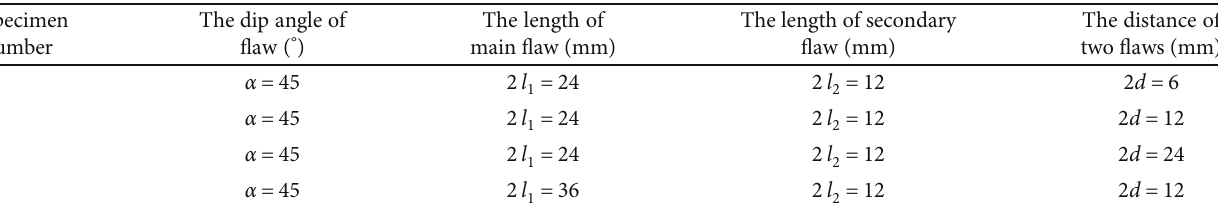
Table 5: Flaw geometric parameters in specimens.